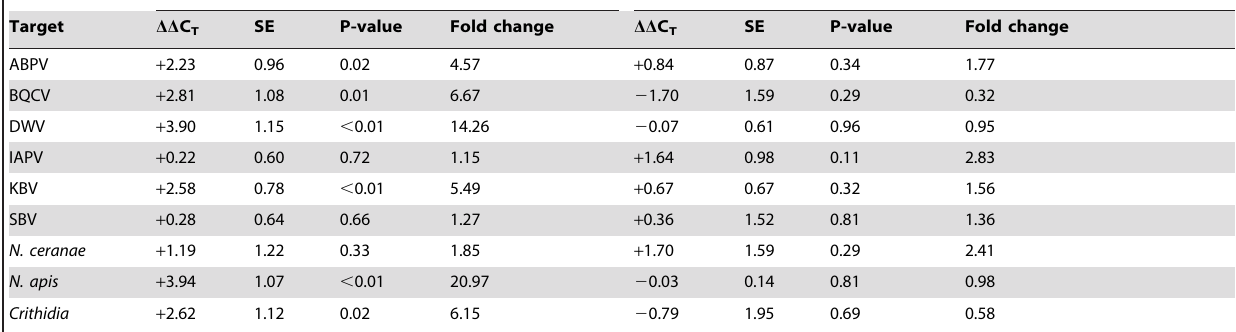
Table 2. Contrasts in honey-bee pathogen abundance by colony